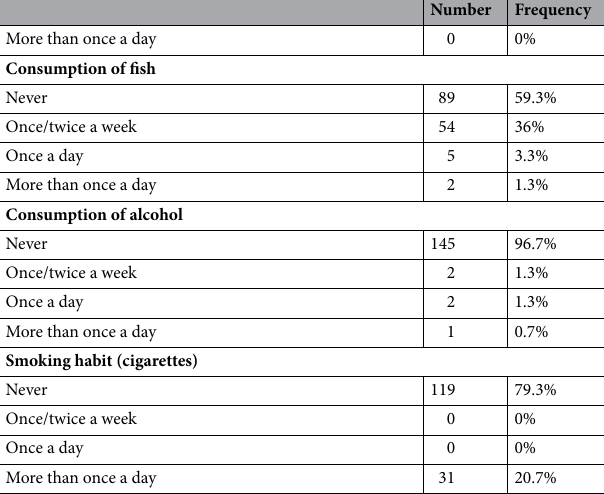
Table 1. Socio-demographic, clinical characteristics and lifestyle-related behaviors of the sample (N = 150).